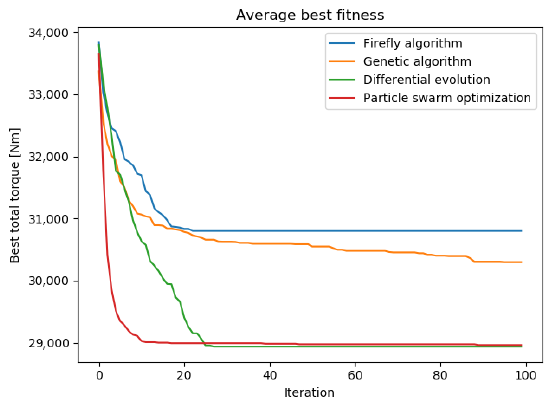
Figure 1. Average best fitness for torque optimization